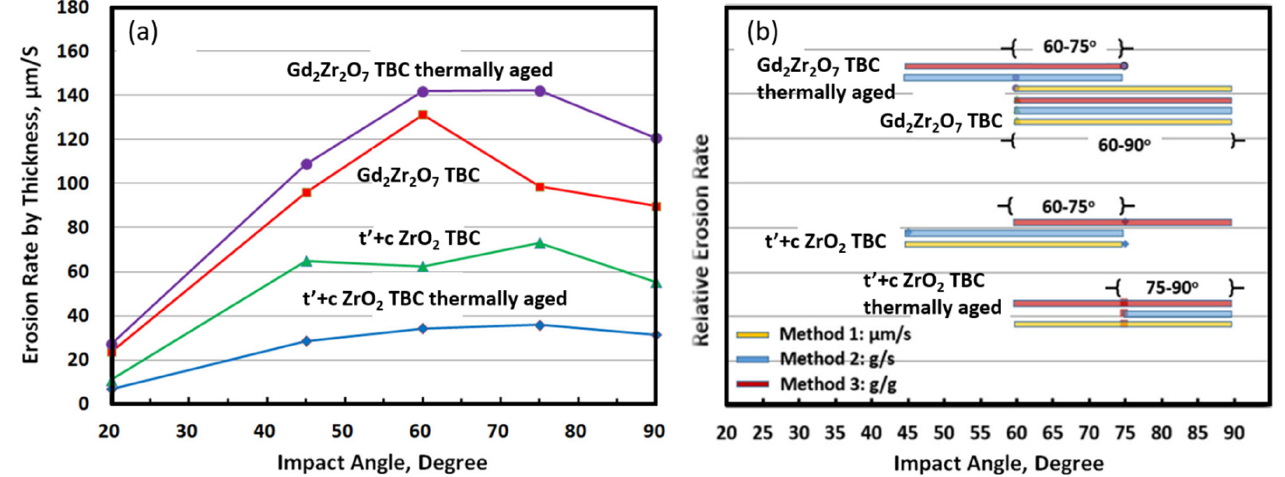
Figure 11. Plots of the results of SPE erosion rates as a function of impingement angle: ( a ) erosion rate measured by the maximum thickness loss per erosion time, µm/s; ( b ) comparison of erosion rates, as characterized by three evaluation methods.